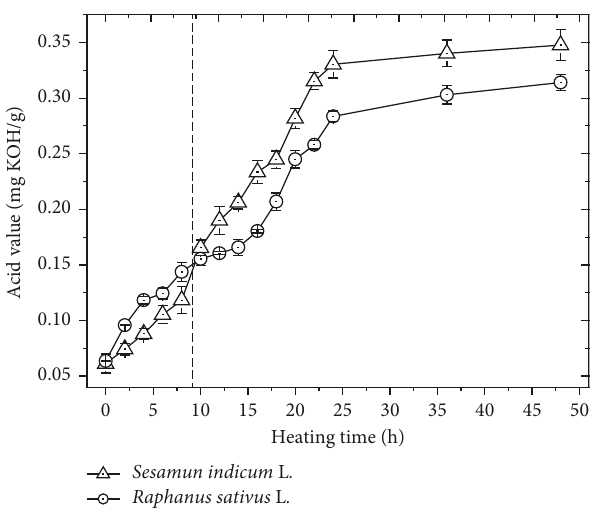
Figure 1: Acidvaluesforbiodieselsfrom S.indicum L.and R.sativus L. during the thermal degradation process. Error bars represent standard